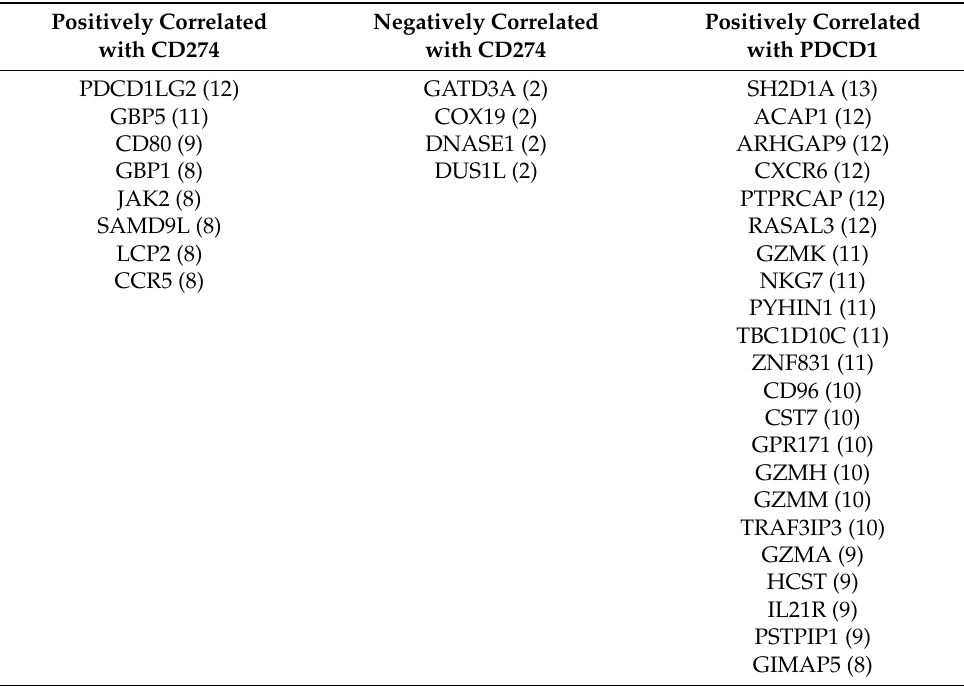
Table 1. Pan-cancer CD274 and PDCD1 co-expressed genes. In brackets after each gene is the number of cancers in which the gene was found to be significantly co-expressed with CD274 or PDCD1. For positive correlations, a gene was taken forward if it appeared in over half (eight of fifteen) of selected cancers. For negative correlations, due to the far smaller number of identified genes, genes were taken forward if they appeared co-expressed in more than one cancer. Genes correlated with PDCD1 underwent a further filtering process to remove co-expressed genes that appeared to be specifically T cell-related rather than tumor-cell related (File